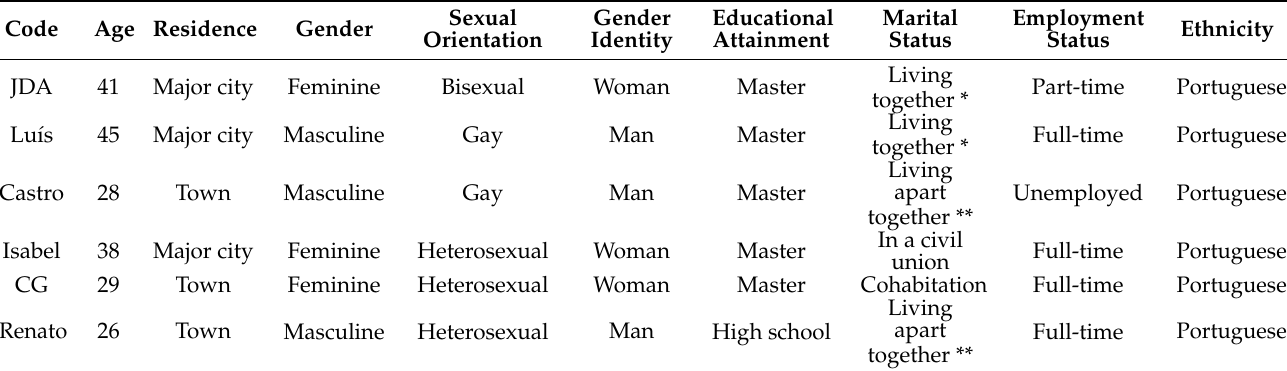
Table 1. Sociodemographic Characteristics of